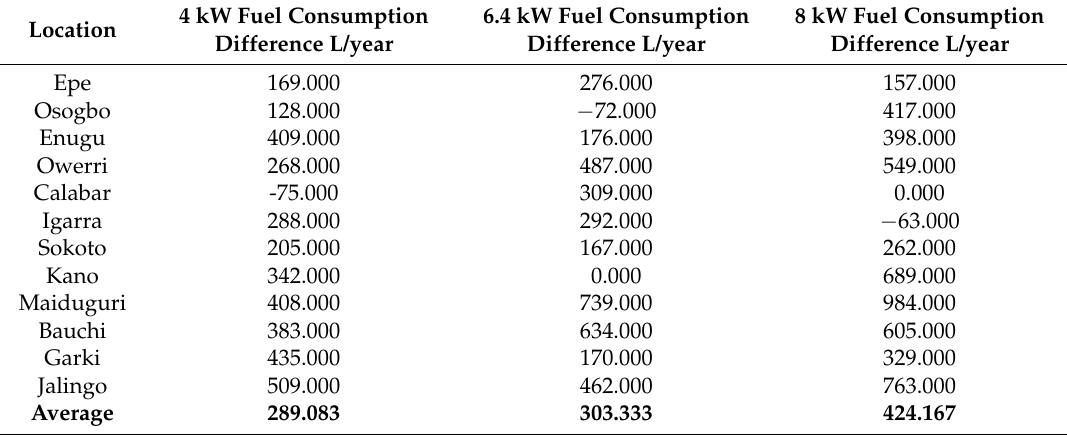
Table 9. Fuel consumption difference for the sites.